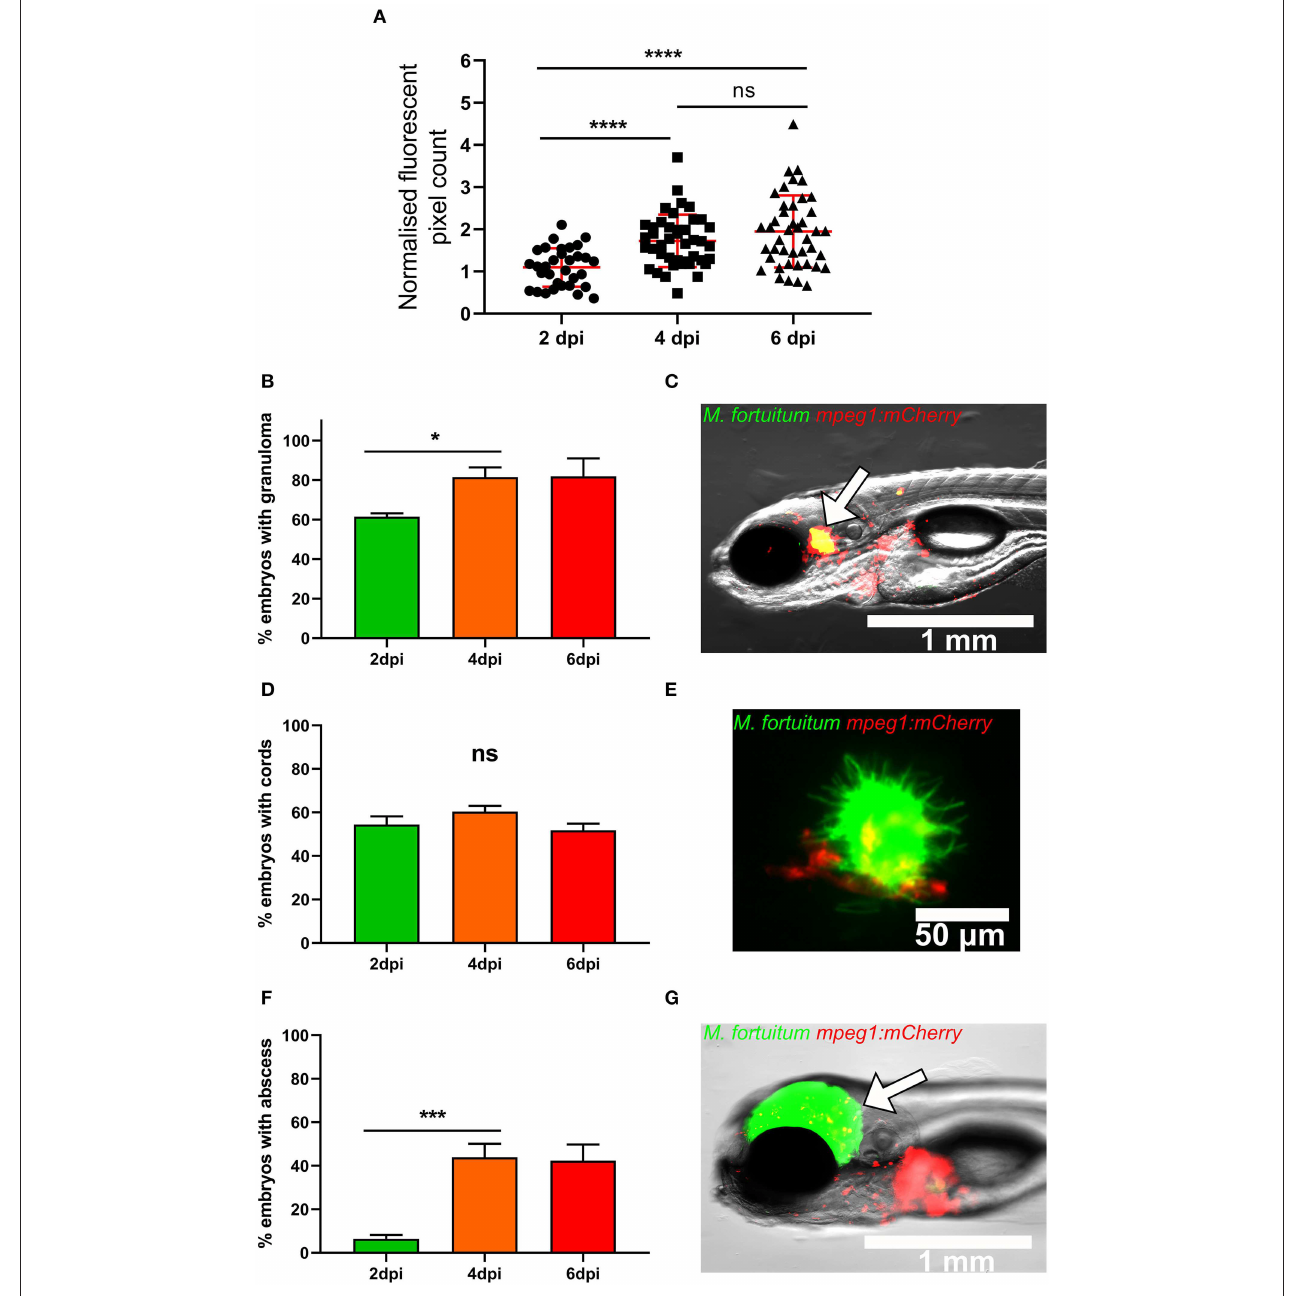
FIGURE 3 | Zebrafish infected with Mycobacterium fortuitum recapitulate the hallmark features of other pathogenic mycobacteria. (A) Following infection mpeg1::mCherry zebrafish embryo at 30h post-fertilization via caudal vein injection with 300 CFU of GFP-expressing M. fortuitum , bacterial burden was quantified using fluorescent pixel count (FPC determination using ImageJ software) at 2, 4, and 6 days post-infection. For each experiment, all groups were normalized against the 2 days post-infection group. Each datapoint represents an individual embryo. Error bars represent standard deviation. Statistical significance was determined by Student ′ s t -test. Plots represent a pool of 2 independent experiments containing approximately 20 embryos per group. (B) The granuloma formation kinetic in embryos following infection with M. fortuitum . Error bars represent standard deviation. Data shown is the merge of two independent experiments. Statistical significance was determined by Student ′ s t -test. (C) Representative image of a granuloma at 4 days post-infection. The white arrow highlights the granuloma. Scale bar represents 1mm. (D) The kinetic of bacterial cord formation in zebrafish embryos following M. fortuitum infection. Error bars represent standard deviation. Data shown is the merge of two independent experiments. Statistical significance was determined by Student ′ s t -test. (E) Representative image of a bacterial corded M. fortuitum aggregate surrounded by recruited macrophages at 4 days post-infection. Note the sheer size of the bacterial aggregate in comparison to the smaller macrophages. Green represents M. fortuitum , while red represents macrophages. Scale bar represents 50 µ m. (F) The kinetic of abscess formation in zebrafish embryos infected with M. fortuitum . Error bars represent standard deviation. Data shown is the merge of two independent experiments. Statistical significance was determined by Student ′ s t -test. (G) Representative image of an M. fortuitum abscess at 4 days post-infection. The white arrow highlights the abscess. Green represents M. fortuitum , while red represents macrophages. Scale bar represents 1mm. * P ≤ 0.05, *** P ≤ 0.001, **** P ≤ 0.0001. Frontiers in Cellular and Infection Microbiology |